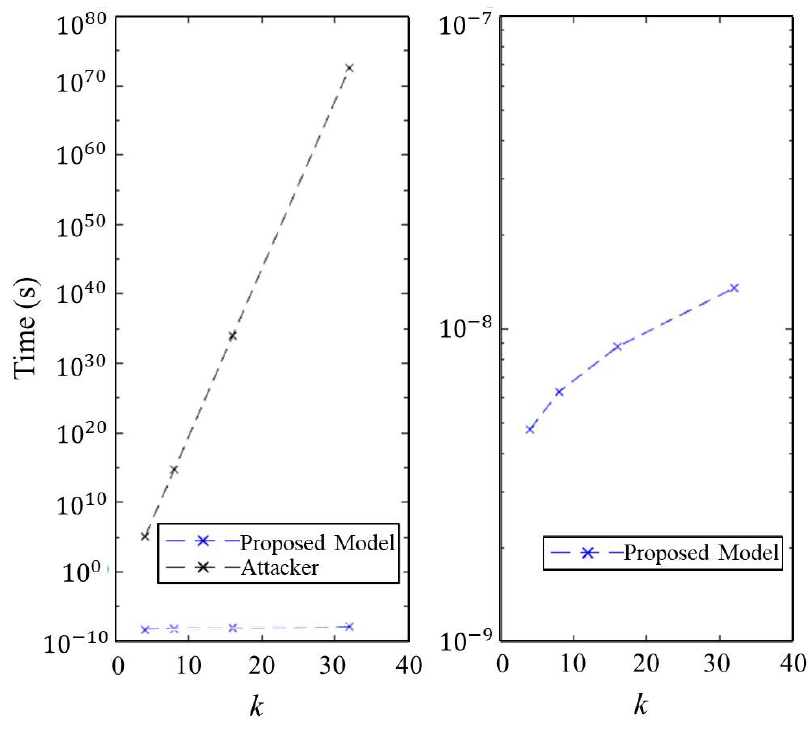
Figure 19. Execution time of an attacker and STT-DPSA to do authentication under n = 8 and l = 2 while varying the parameter k .